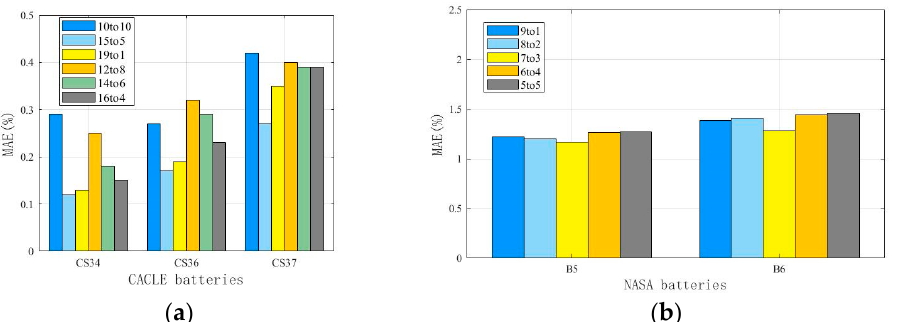
Figure 10. Performance of different sequence length: ( a ) CACLE dataset; ( b ) NASA dataset.